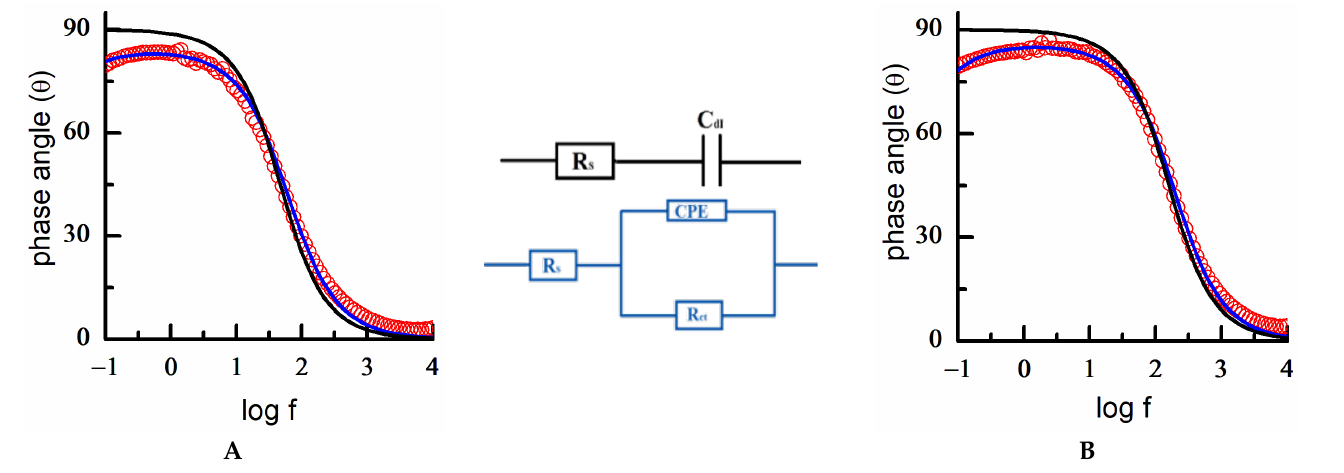
Figure 6. Electrochemical impedance spectra. Experimental Bode plot data of a square plate of 18K gold alloy (red circles) in ( A ) 10 mM HClO 4 and ( B ) 0.1 NaOH. Experimental data (red circles) are fitted to a [R(QR)] equivalent circuit (blue lines). A simulated RC equivalent circuit is included for comparison (black lines). E = −0 .3 V. Schemes of the RC and [R(QR)] circuits are